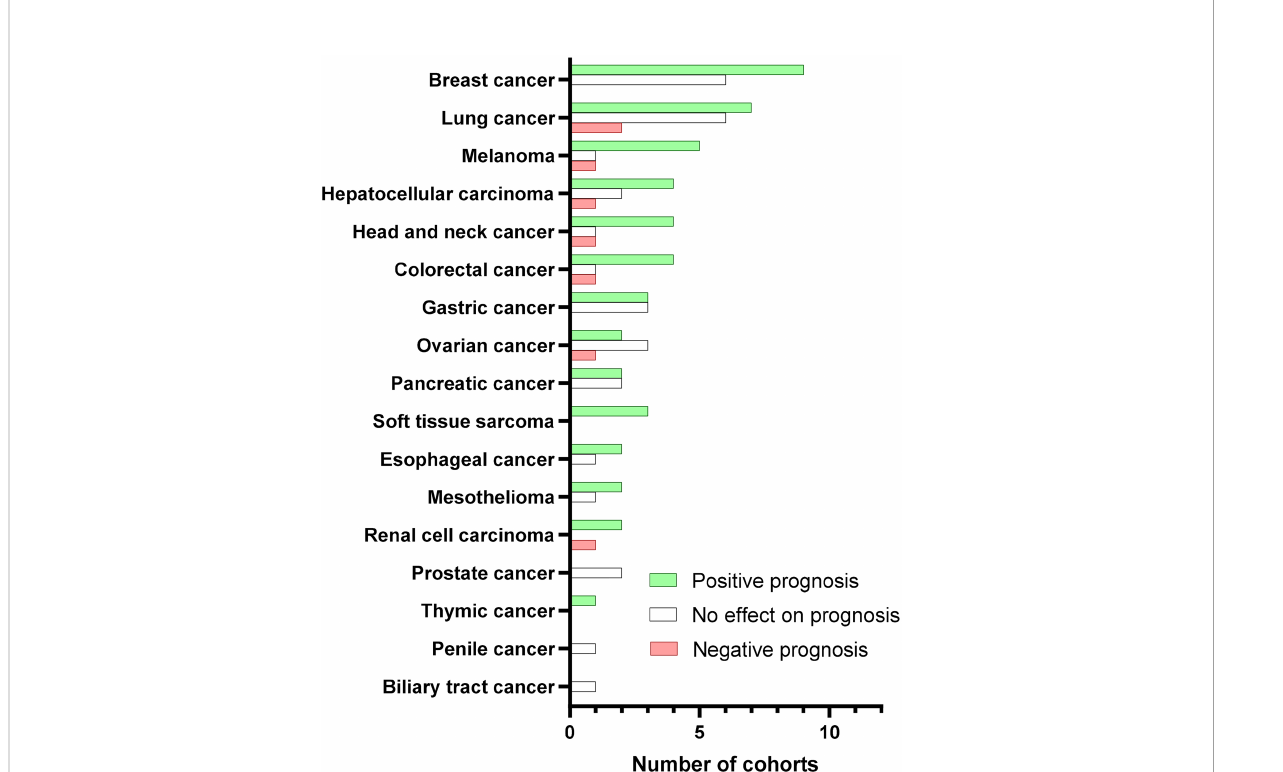
FIGURE 2 Prognostic value of CD20 + TIBs according to cancer type. Bars represent the number of cohorts with positive (green), no effect (white), or negative (red) prognostic signi fi cance for the indicated cancer types. We searched PubMed for peer-reviewed articles reporting on the prognostic value in human solid tumors due to the obvious confounding issues. The following search terms and logic gates were used for the PubMed search: “ B-cell ” AND “ cancer ” AND “ prognosis ”